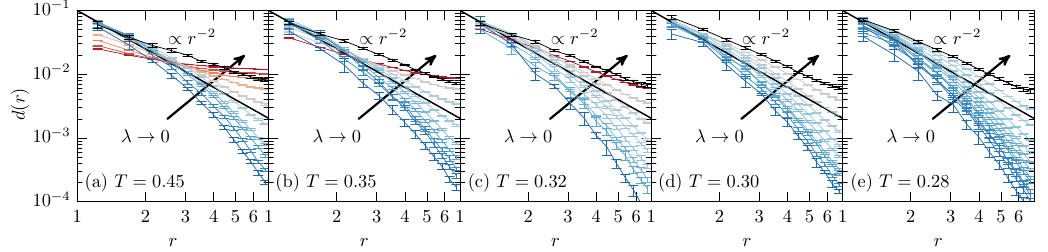
Figure 3: Decay profiles for saddles at (a) T = 0.45, (b) T = 0.35, (c) T = 0.32, (d) T = 0.30, and (e) T = 0.28. The solid lines are proportional to r − 2 . The continuous change in color from blue to red corresponds to the change of λ shown in Tab. 4. We show the data above the mobility edge in red, those below the mobility edge in blue. For comparison, we show the data the QLVs in black.